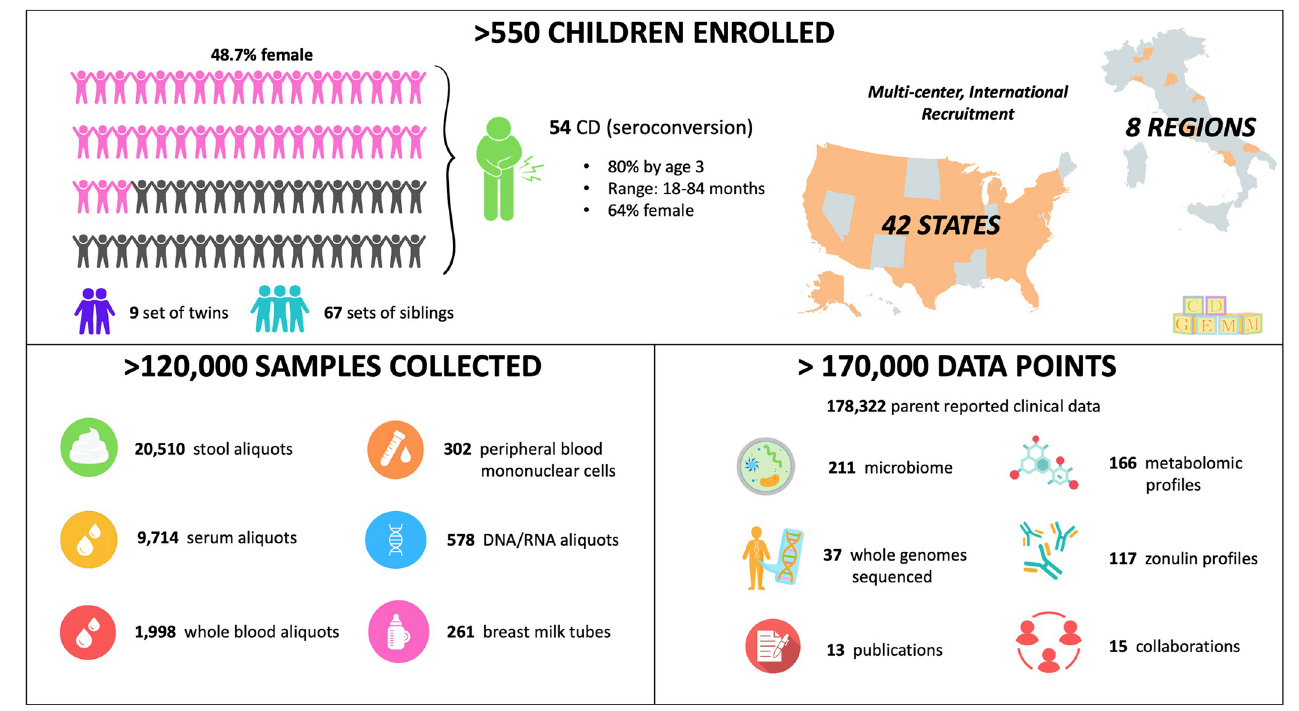
Fig 2. CDGEMM sample and data overview. Summary of CDGEMM cohort enrollment. The total number and types of samples collected and data points generated are provided.